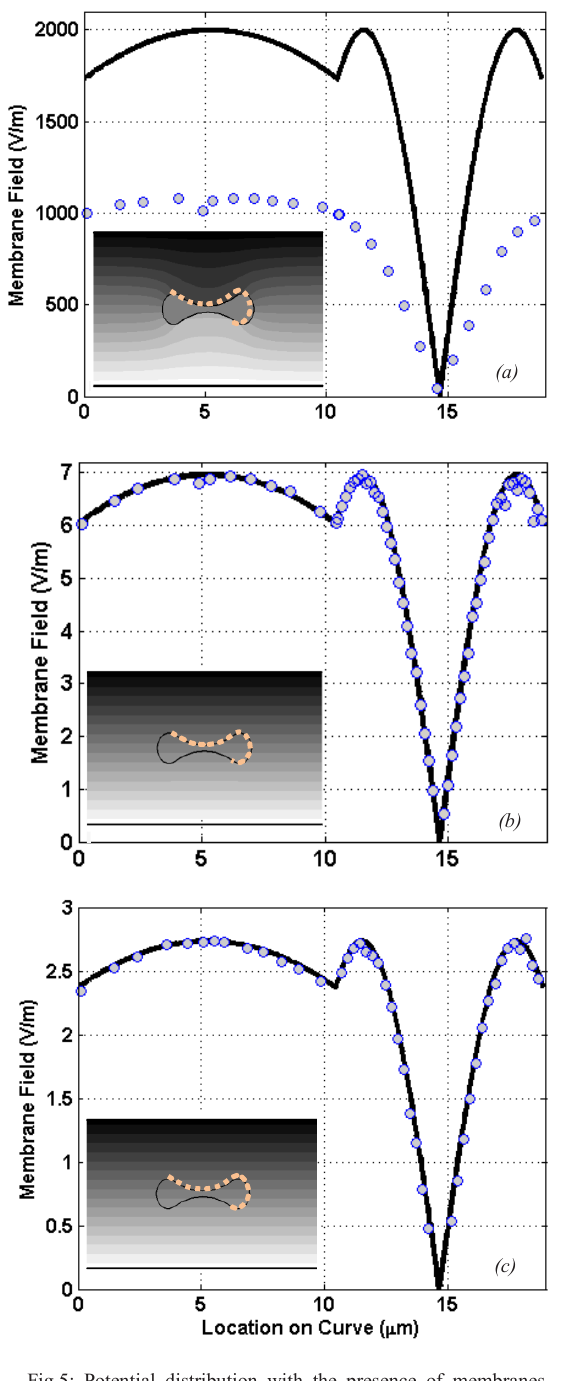
Fig.5: Potential distribution with the presence of membranes, and normal electric field in the membrane (along the dashed curve in the cell membrane); solid line: results of removing membranes in the numerical model and retrieval of membrane fields using (Eq.6), Markers: exact numerical computation of membrane fields, for (a) 1MHz, (b) 1GHz, (c) 500